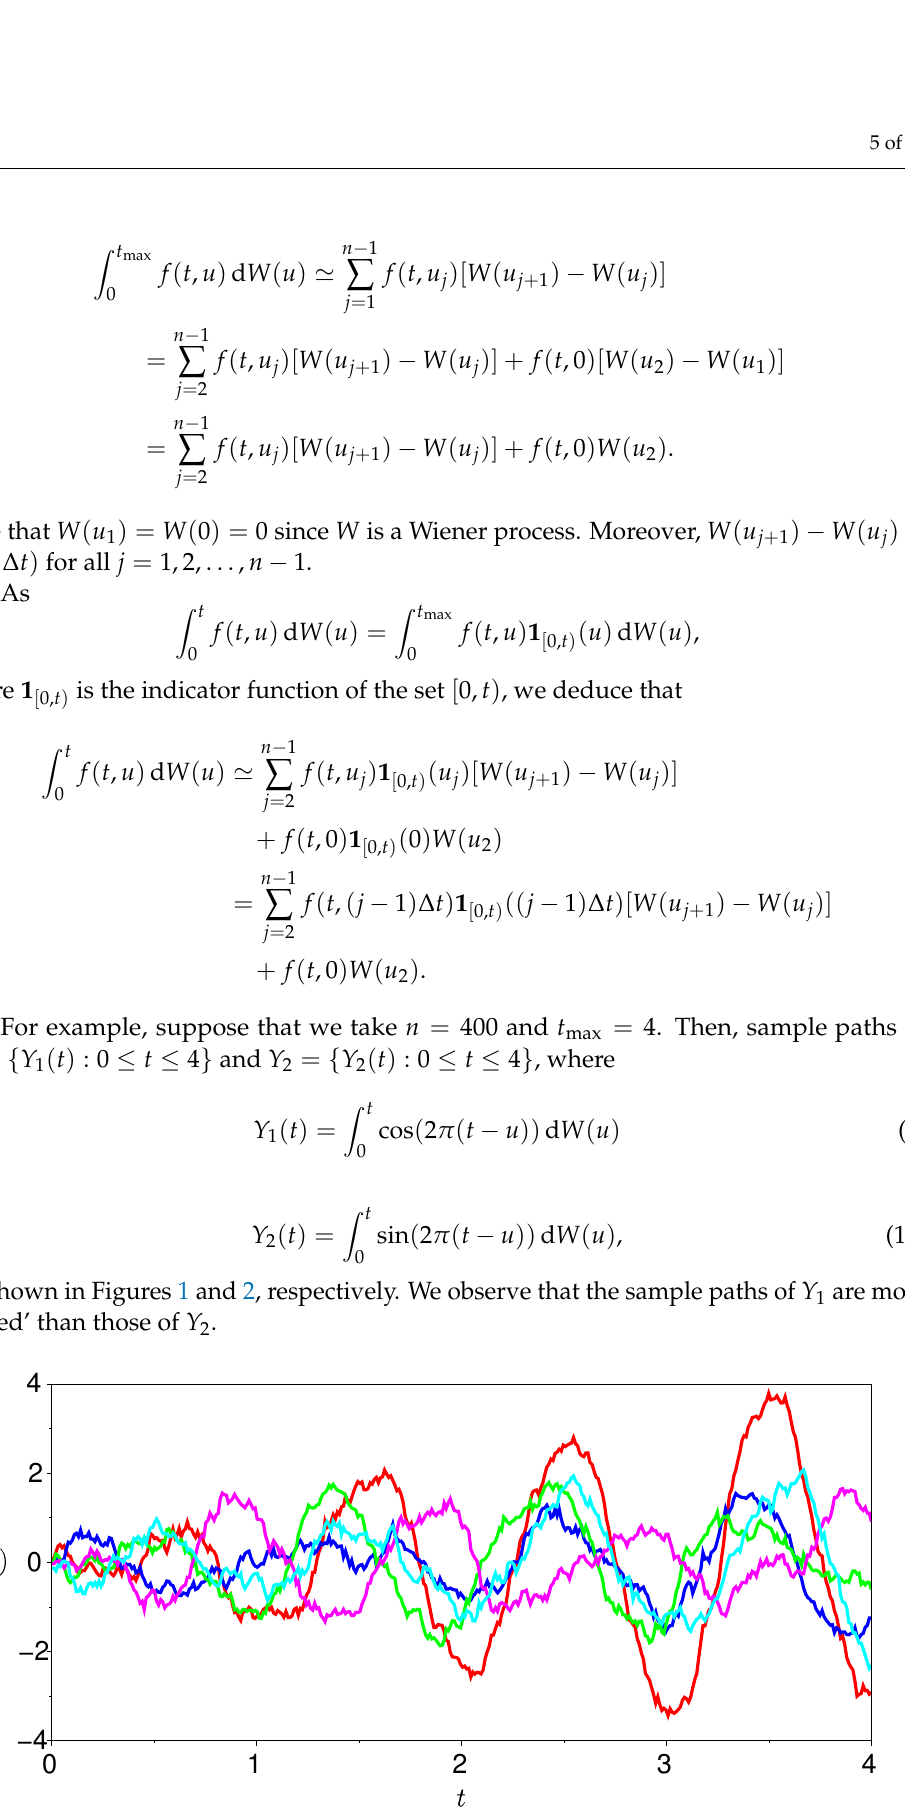
Figure 1. Five sample paths generated by Y 1 = { Y 1 ( t ) : 0 ≤ t ≤ 4 } , where Y 1 is given in